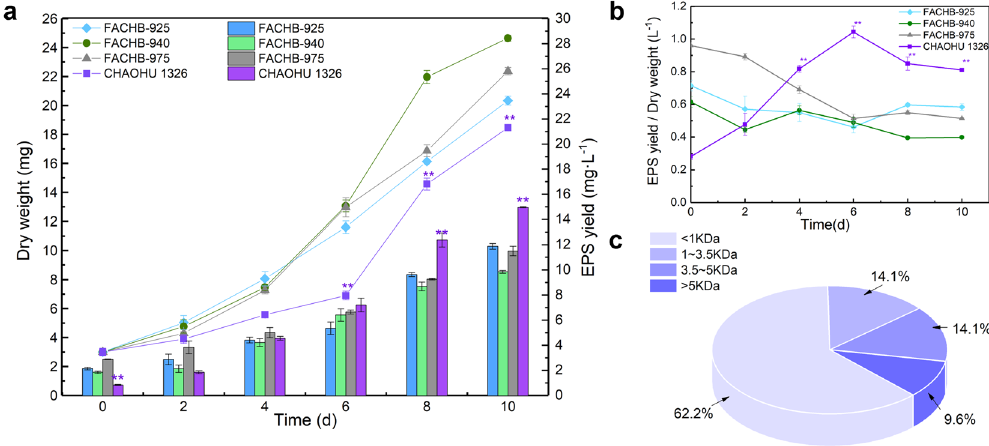
Figure 5. Soluble EPS produced by the M. aeruginosa strains during growth in BG11 medium. The EPS yields are displayed by the columns and the growth curves of different strains are displayed by lines in panel a. The ratios of EPS yield to the dry cell weight of the different strains are shown in panel b. The molecular weight distribution of soluble EPS produced by M. aeruginosa CHAOHU 1326 is shown in panel c. Error bars represent standard deviation in at least triplicate. A statistical difference of p < 0.01 is marked with asterisks ( ** ).